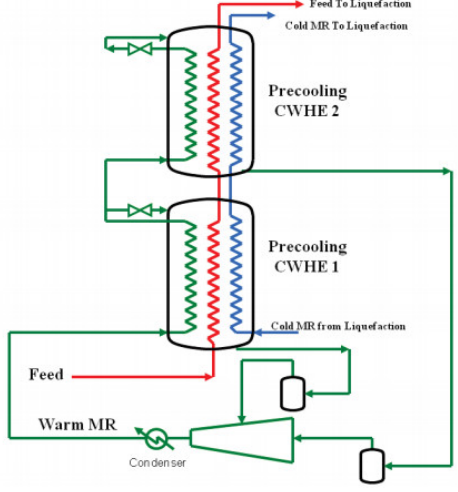
Figure 42. Two Pressure DMR Precooler [161]. Reproduced with permission from Elsevier (license number